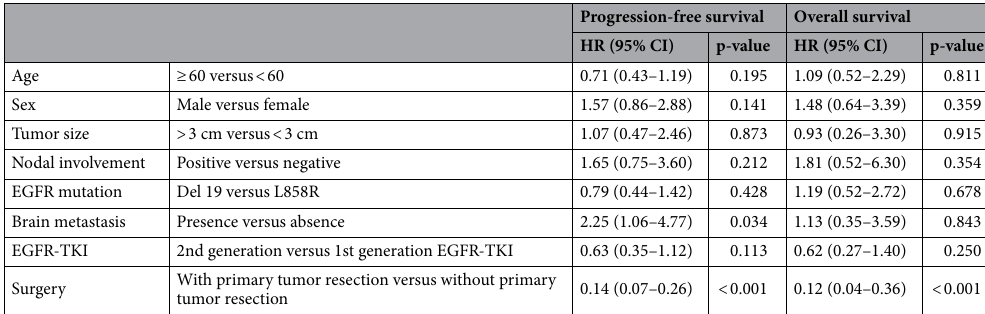
Table 3. Cox proportional hazards regression for progression-free survival and overall survival of newly diagnosed patients. EGFR epidermal growth factor